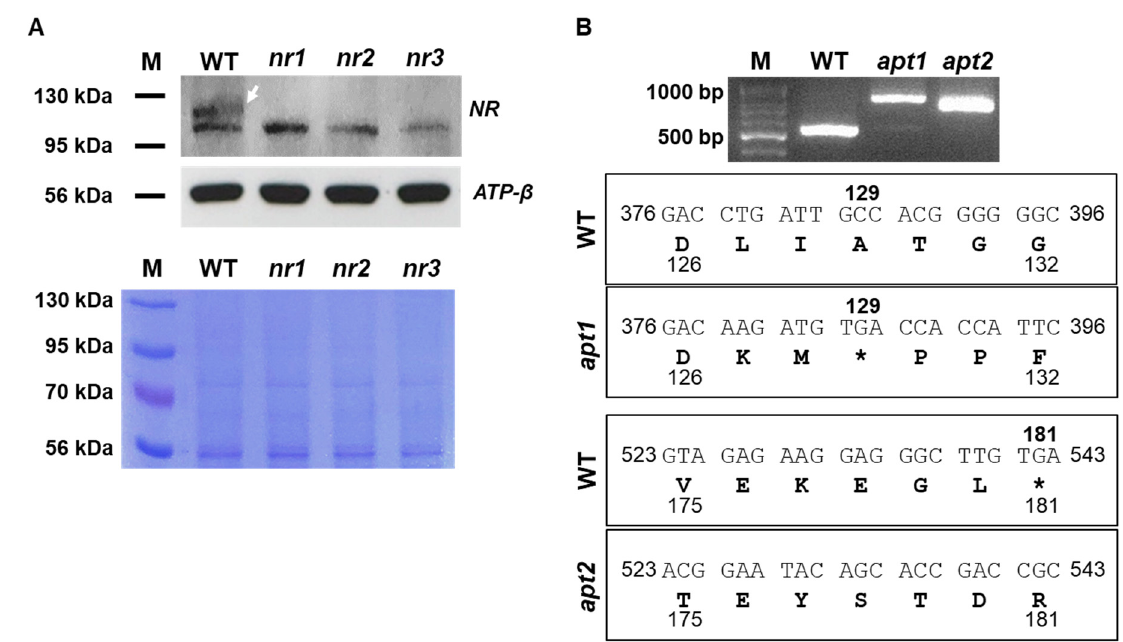
Figure 4. Expression of NR and APT in edited mutants compared with the WT. ( A ) Western blot analysis with a specific antibody against nitrate reductase (upper panel). Total protein content was assessed by Coomassie staining (lower panel). ATP- β was used as a reference protein. ( B ) Comparison of gene and amino acid sequence of APT between edited mutants and the WT. PCR amplification of APT from cDNA of apt mutants and WT cells (upper panel) and corresponding sequences (lower panels), showing the presence of frameshift mutations. M: size marker.